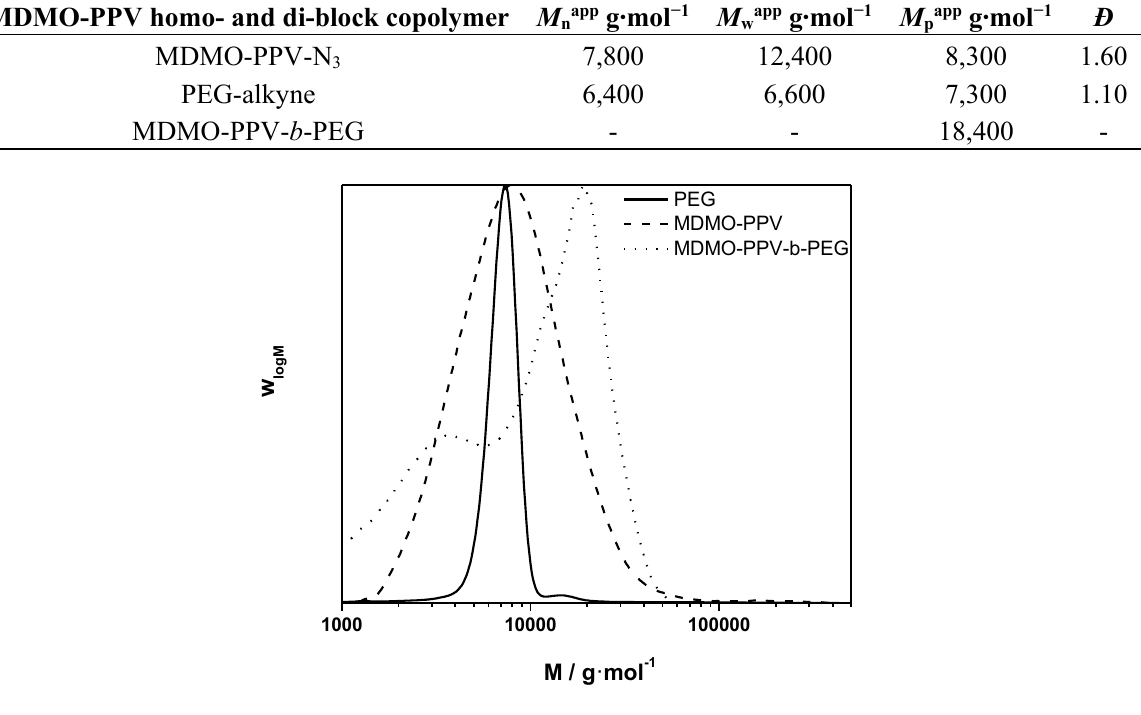
Figure 7 . SEC profile for the direct coupling of alkyne-functionalized PEG to azide functionalized eliminated MDMO-PPV using click conditions without purification of the homopolymer